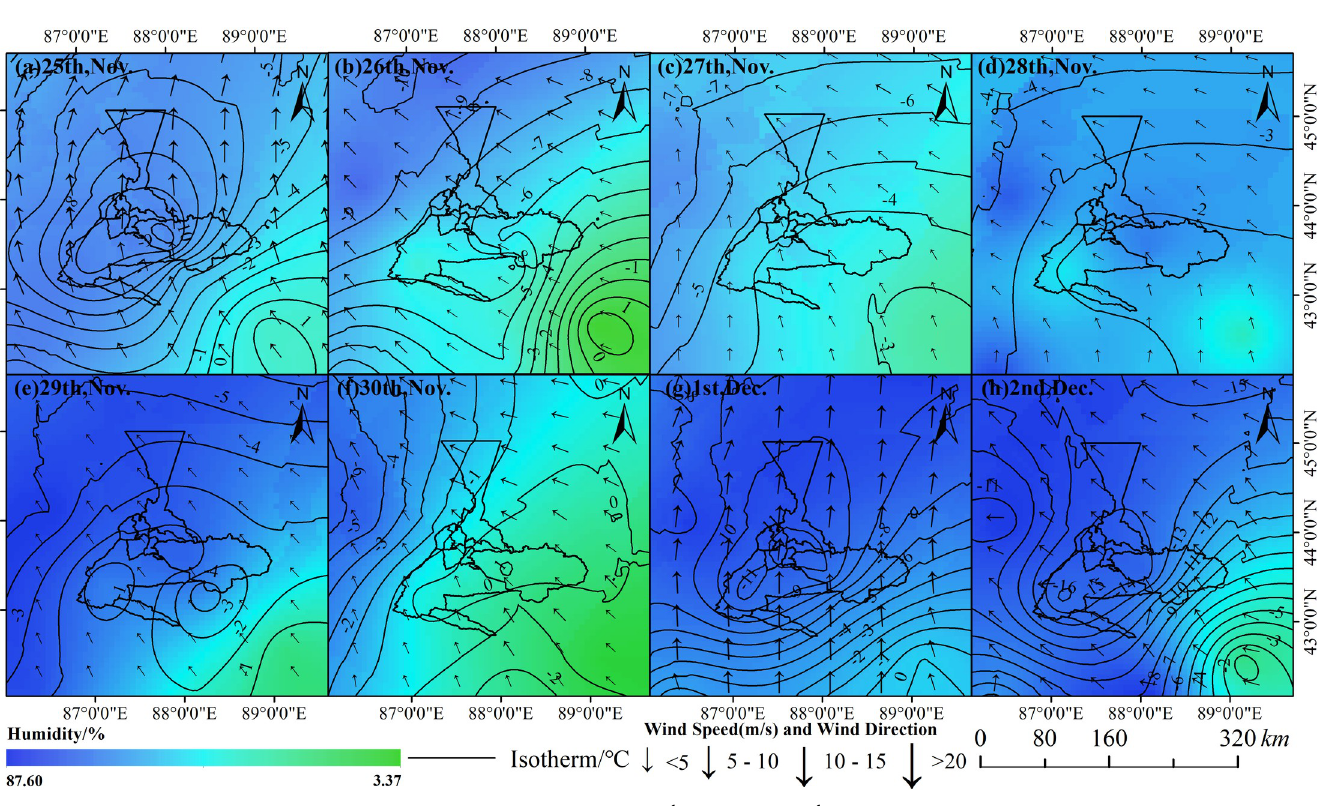
Fig 9. Weather conditions in Urumqi and its surrounding areas from November 25 th to December 2 nd , 2018.